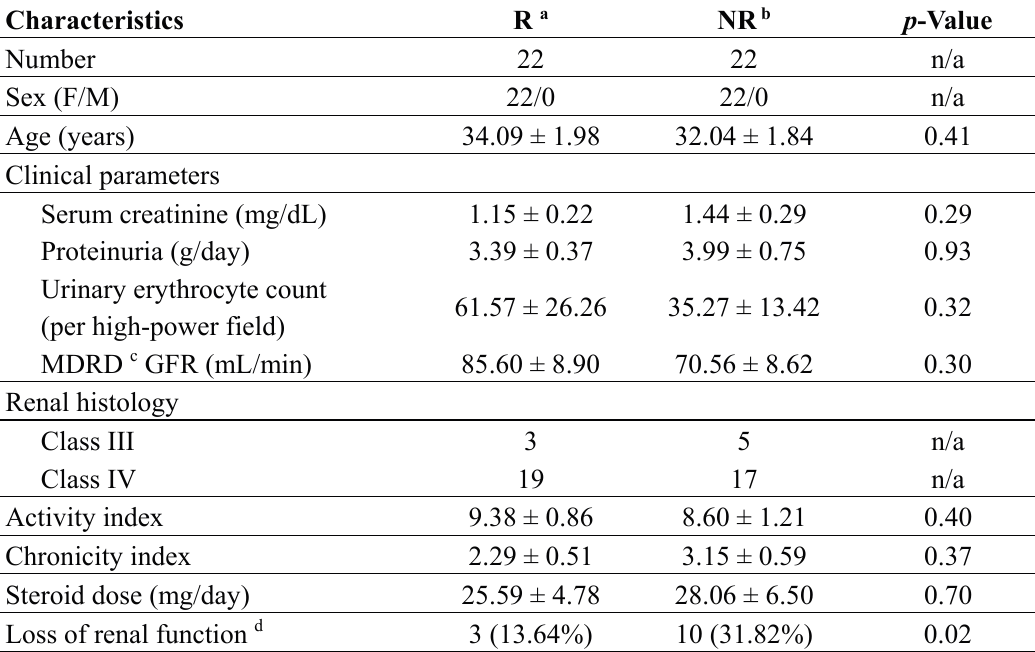
Table 2. Characteristics of the patients in the validation